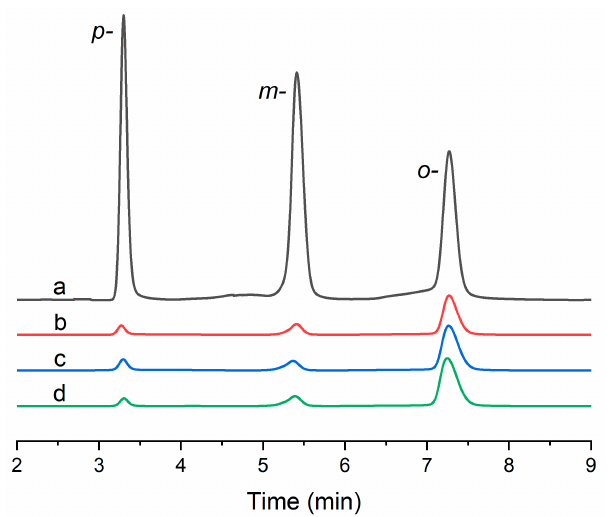
Figure 11. Chromatograms of mixed solution of o-dihydroxybenzene, m-dihydroxybenzene and p-dihydroxybenzene ( a ) and the chromatograms of the eluent for Fe 3 O 4 @MPS@MPBA ( b ), Fe 3 O 4 @MPTES@AAPBA ( c ) and Fe 3 O 4 @MPTES@VPBA ( d ) after being adsorbed in the mixture solution. Peak area ratio of o -dihydroxybenzene to m - and p -: 1:0.12: 0.06 ( b ), 1:0.26: 0.17 ( c ), 1:0.21:0.14 ( d